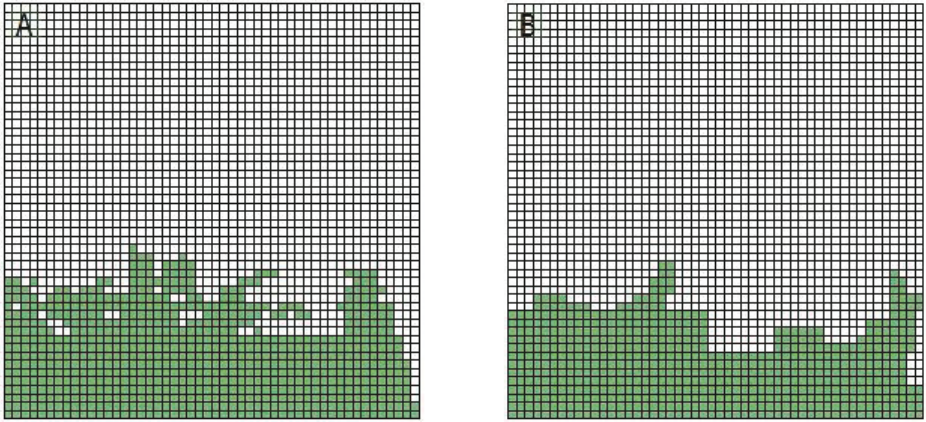
Figure 4. Covered area of protonema of Hypnum cupressiforme (33%, A ) and Eurhynchium hyans (24%, B ). Represented area: 0.5 x 0.5